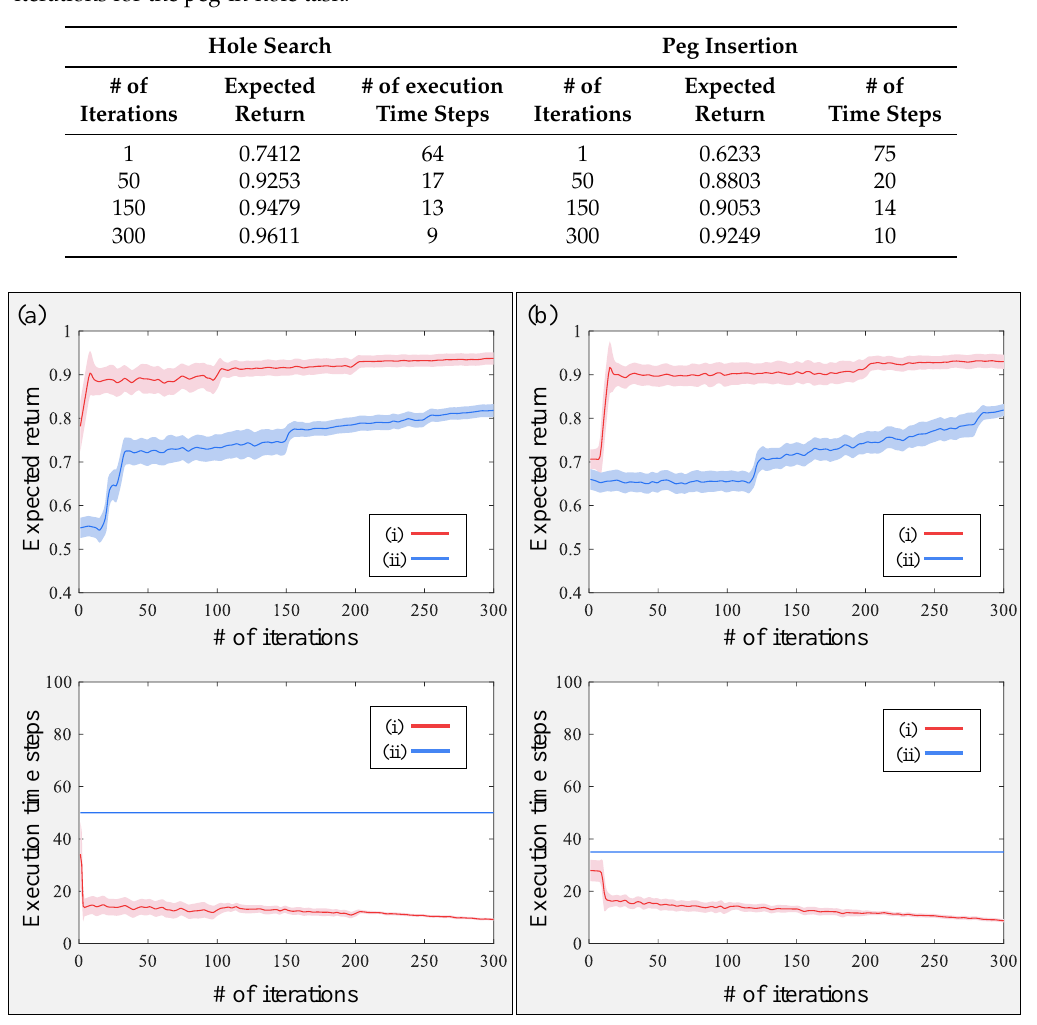
Figure 8. Performance with respect to two reward functions and the original PoWER and iPoWER algorithm in the peg-in-hole task for the motor skills: ( a ) “hole search”; and ( b ) “peg insertion”. The upper and lower rows illustrate the return values and number of execution time steps, respectively. The red lines indicate the results using the iPoWER algorithm, and the blue lines indicate the results using the original PoWER